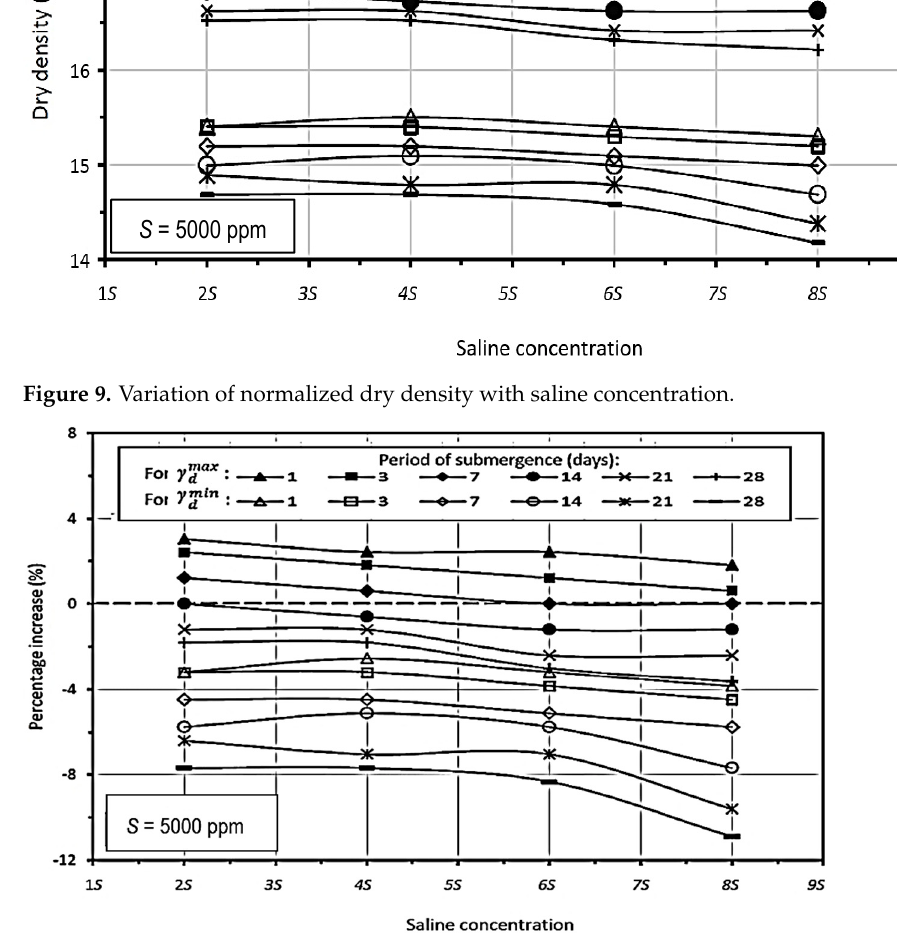
Figure 10. Variation of percentage increase in dry density with saline concentration.